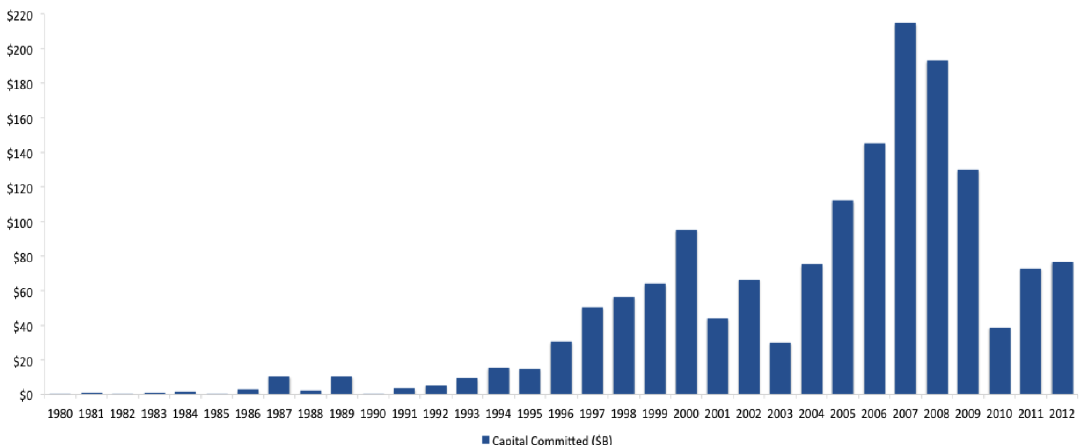
Figure 2: Limited Partner Capital Commitments to Private Equity prices because abundant debt and equity blinded them to the actual cost of this